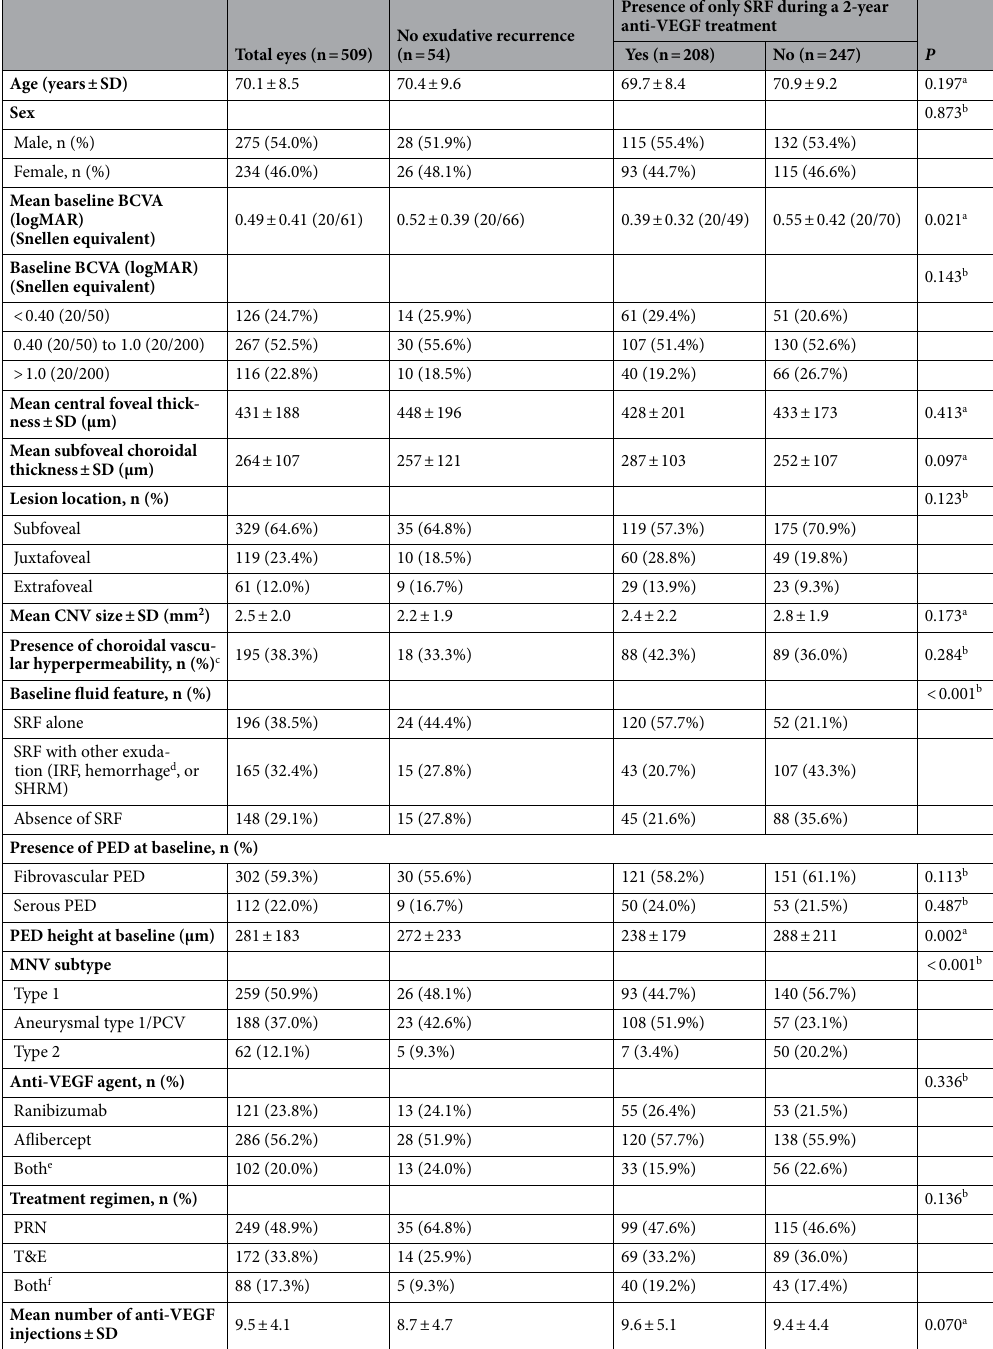
Table 1. Baseline clinical characteristics of patients with neovascular AMD. AMD, age-related macular degeneration; BCVA, best-corrected visual acuity; CNV, choroidal neovascularization; IRF, intraretinal fluid; logMAR, logarithm of the minimum angle of resolution; MNV, macular neovascularization; PCV, polypoidal choroidal vasculopathy; PED, pigment epithelial detachment; PRN, pro-re-nata; SD, standard deviation; SHRM, subretinal hyperreflective material; SRF, subretinal fluid; T&E, treat-and-extend; VEGF, vascular endothelial growth factor. a p -value by analysis of variance. b p -value by chi-square test. c Indocyanine green angiography image was not available for 38 eyes among the total eyes. d Refers to any hemorrhage, not necessarily limited to the lesion, including subretinal and sub-RPE hemorrhage. e Patients switched from an anti-VEGF drug to the other one during the study period; 74 eyes (72.5%) were switched from ranibizumab to aflibercept, while the others were switched from ranibizumab to aflibercept. f Treatment regimen was switched from PRN to T&E in 52 (59.1%) eyes and from T&E to PRN in others (40.9%) during the study